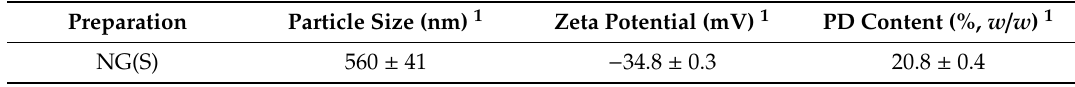
Table 1. Particle characteristics and drug content of NG(S).